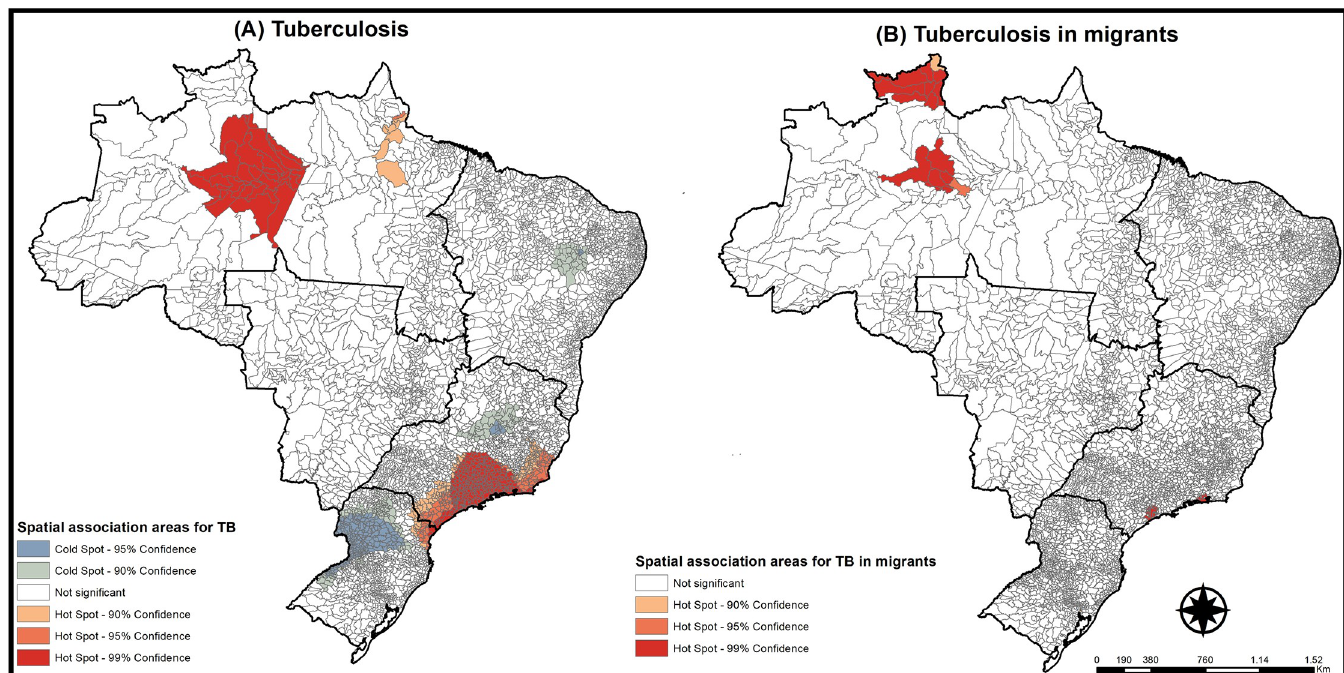
Fig 2. High and low tuberculosis clusters in the general population and in migrants, Brazil (2014–2019). Source: prepared by the authors.